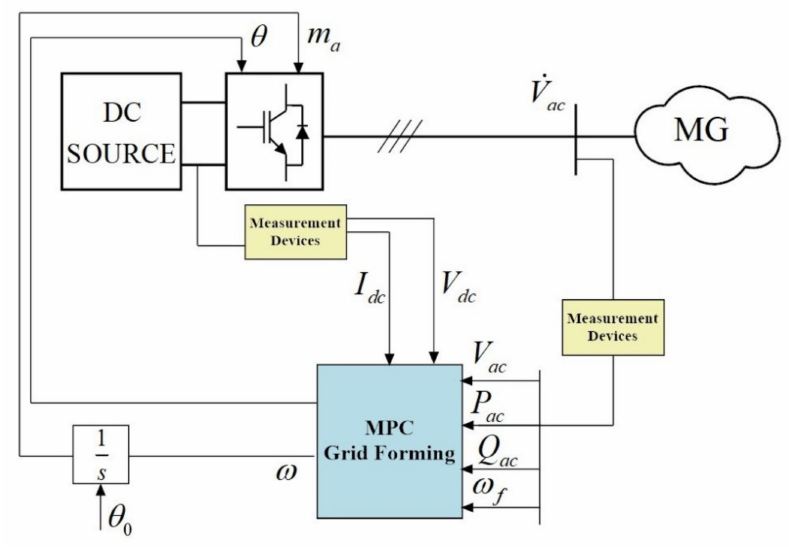
Figure 6. Generic DG unit control scheme